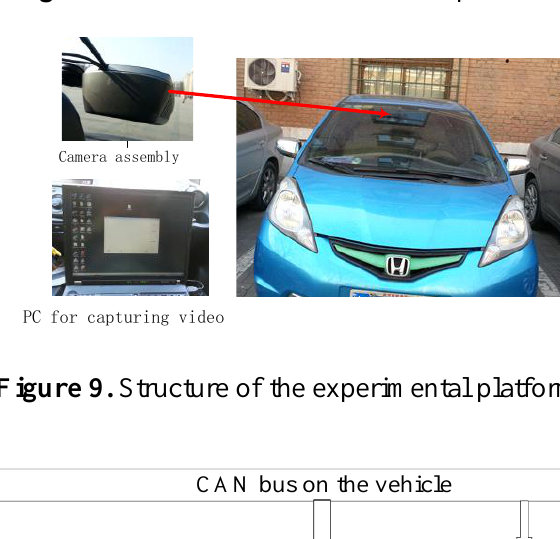
Figure 8. Platform for the vehicle experiment.